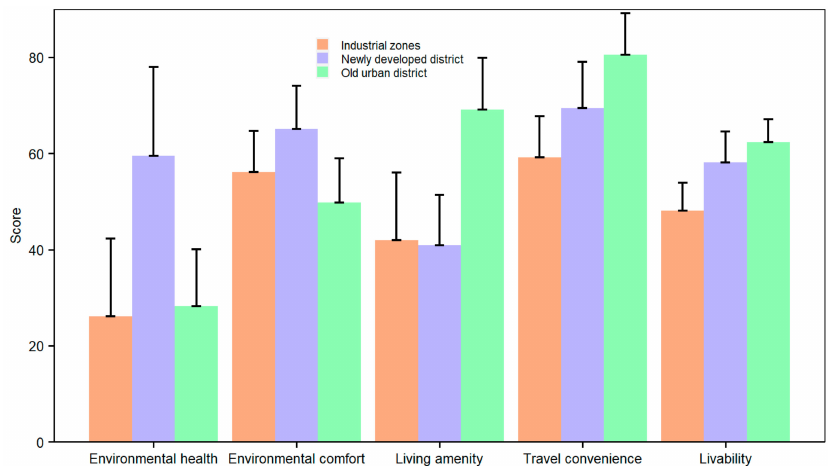
Figure 8. Average scores of di ff erent livability dimensions summarized by urban functional types and overall livability scores summarized by urban functional